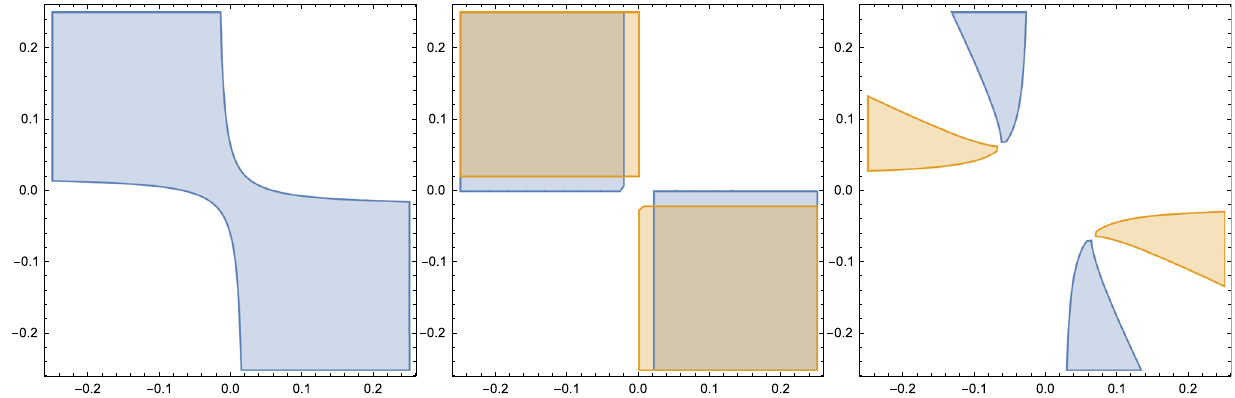
Fig. 1 Regions (blue) in the parameter space ( p 21 , p 22 ) where good AdS 3 vacua exist. From left to right, these are the cases of ( k 1 = k 2 = − 1 ) , ( k